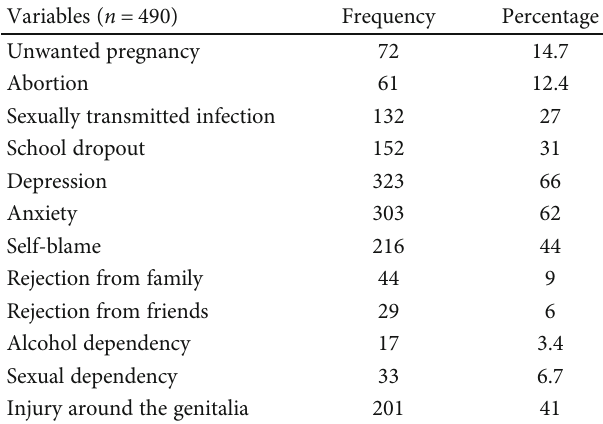
Table 3: Consequence of gender-based violence among female night students in a public institution of Bahir Dar city, Amhara Region, Ethiopia, 2019.